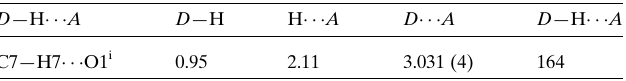
Table 3 Hydrogen-bond geometry (A˚ , (cid:2) ) for 3